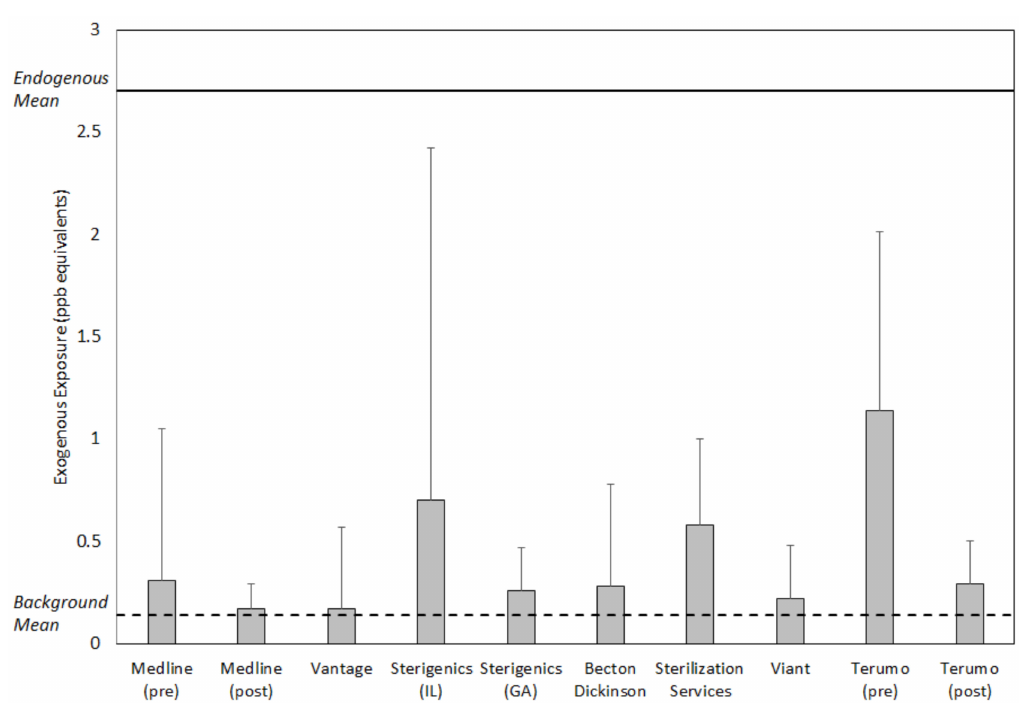
Figure 3. Mean (top of box) and SD (whisker) of ambient air EO concentrations in the vicinity of eight sterilization and other EO-emitting industrial facilities, relative to overall facility-specific background mean EO concentration (0.14 ppb) and